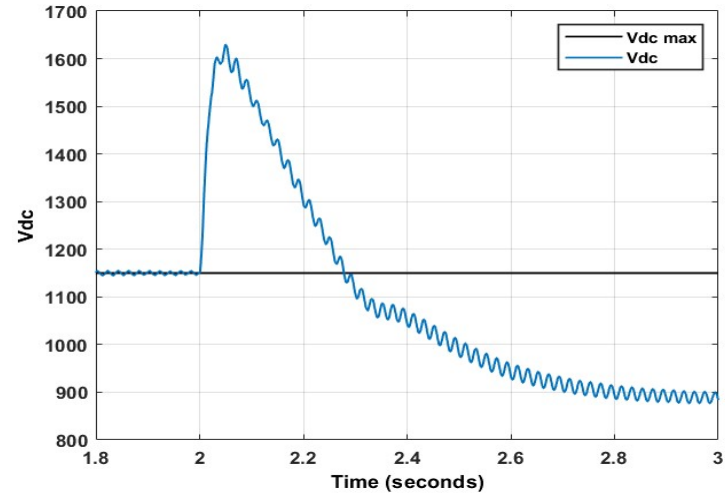
Figure 16. DC voltage transient using AVOA at 80% dip.